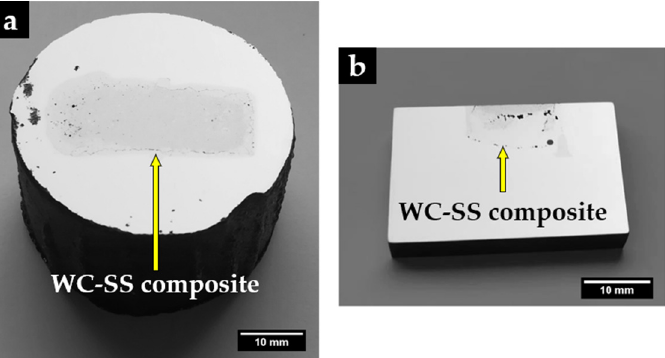
Figure 8. The reinforced specimen ( a ) and a cut through the cross-section ( b ), showing the depth of the composite zone.